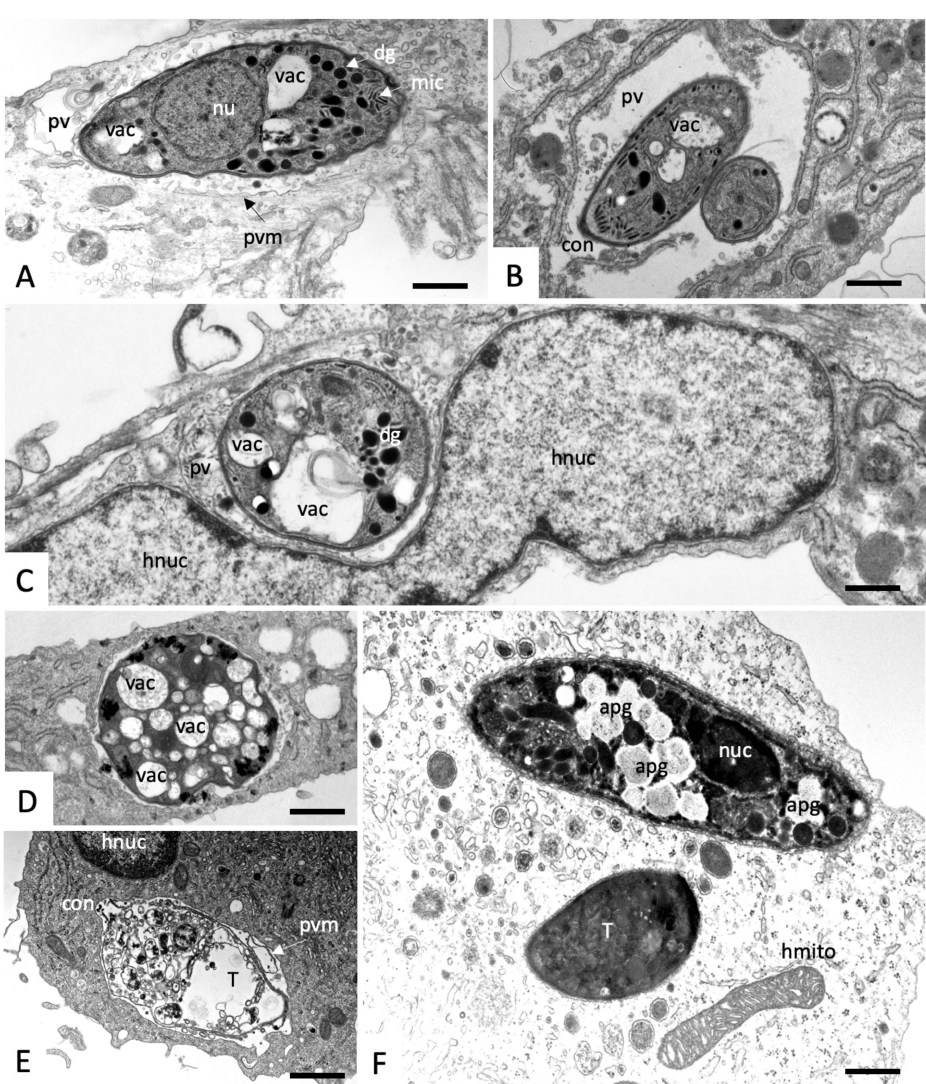
Figure 5. TEM of N. caninum tachyzoite-infected HFF treated with a 500 nM compound (1) and fixed and processed at di ff erent timepoints after the treatment began ( A , B ) = 6 h; ( C ) = 12 h; ( D ) = 24 h; ( E , F ) = 48 h. apg = amylopectin granules, dg = dense granules, hmito = host cell mitochondrion, hnuc = host cell nucleus, mic = micronemes, pv = parasitophorous vacuole, pvm = parasitophorous vacuole membrane, T = tachyzoite, vac = vacuolization. The bar in ( A ) = 0.6 µ m; ( B ) = 0.8 µ m; ( C ) = 0.4 µ m; ( D ) = 0.5 µ m; ( E , F ) = 0.8 µ